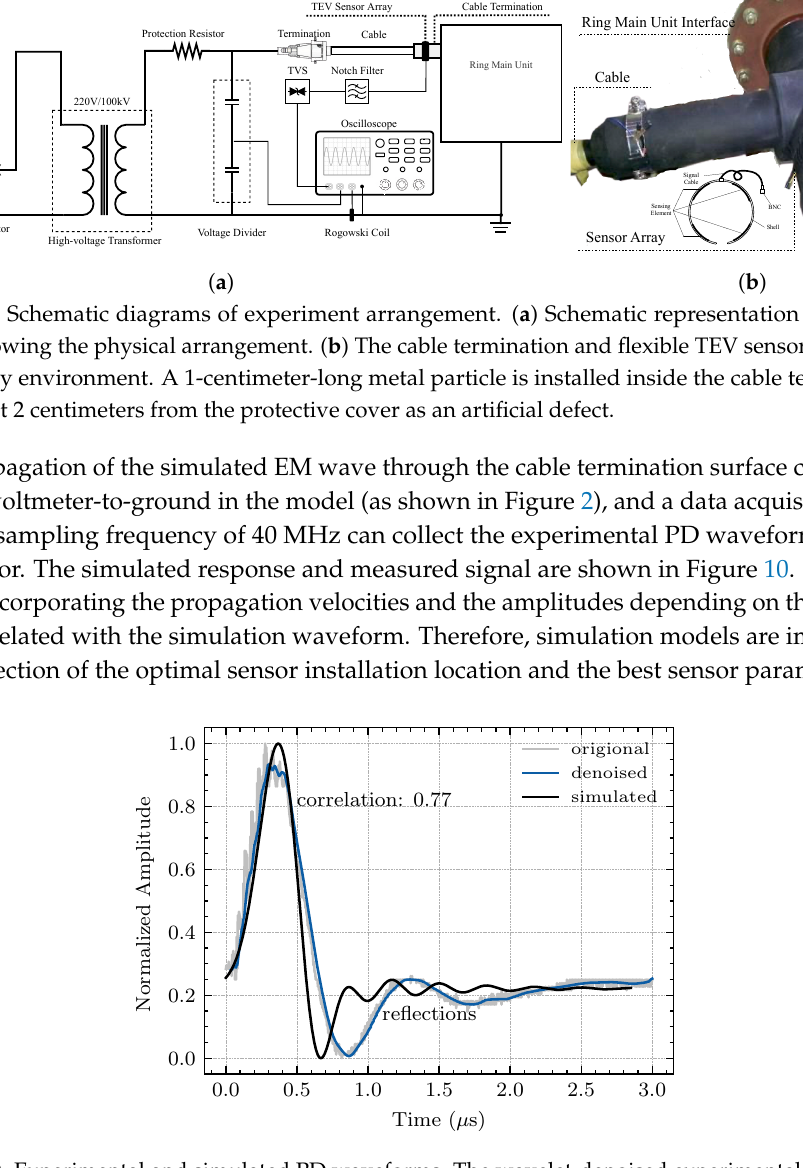
Figure 10. Experimental and simulated PD waveforms. The wavelet-denoised experimental waveform has a strong correlation with the simulated